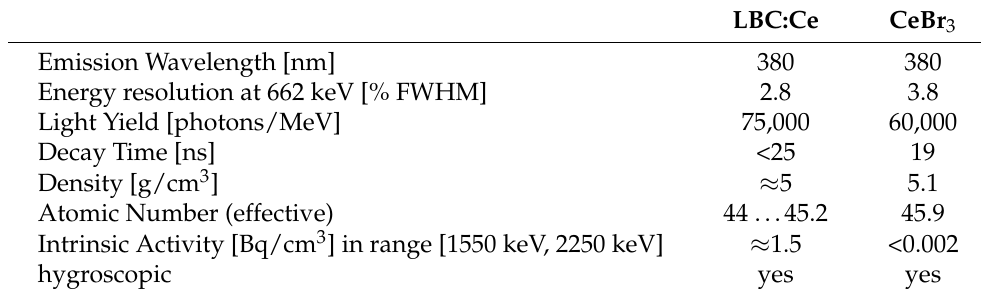
Table 1. Characteristics of LBC:Ce and CeBr 3